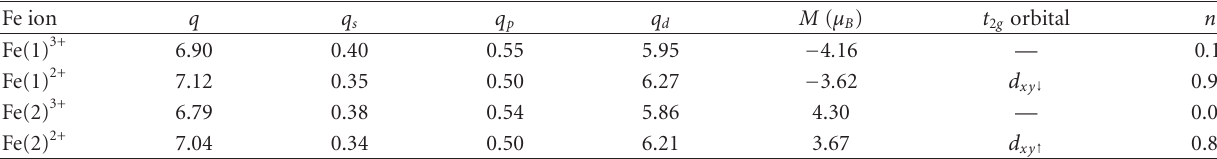
Table 3: Total and l -projected charges, magnetic moments, and occupation of the most populated t 2 g orbitals calculated for inequivalent Fe atoms in the low-temperature P 2 1 /c phase of Fe 2 OBO 3 [211].